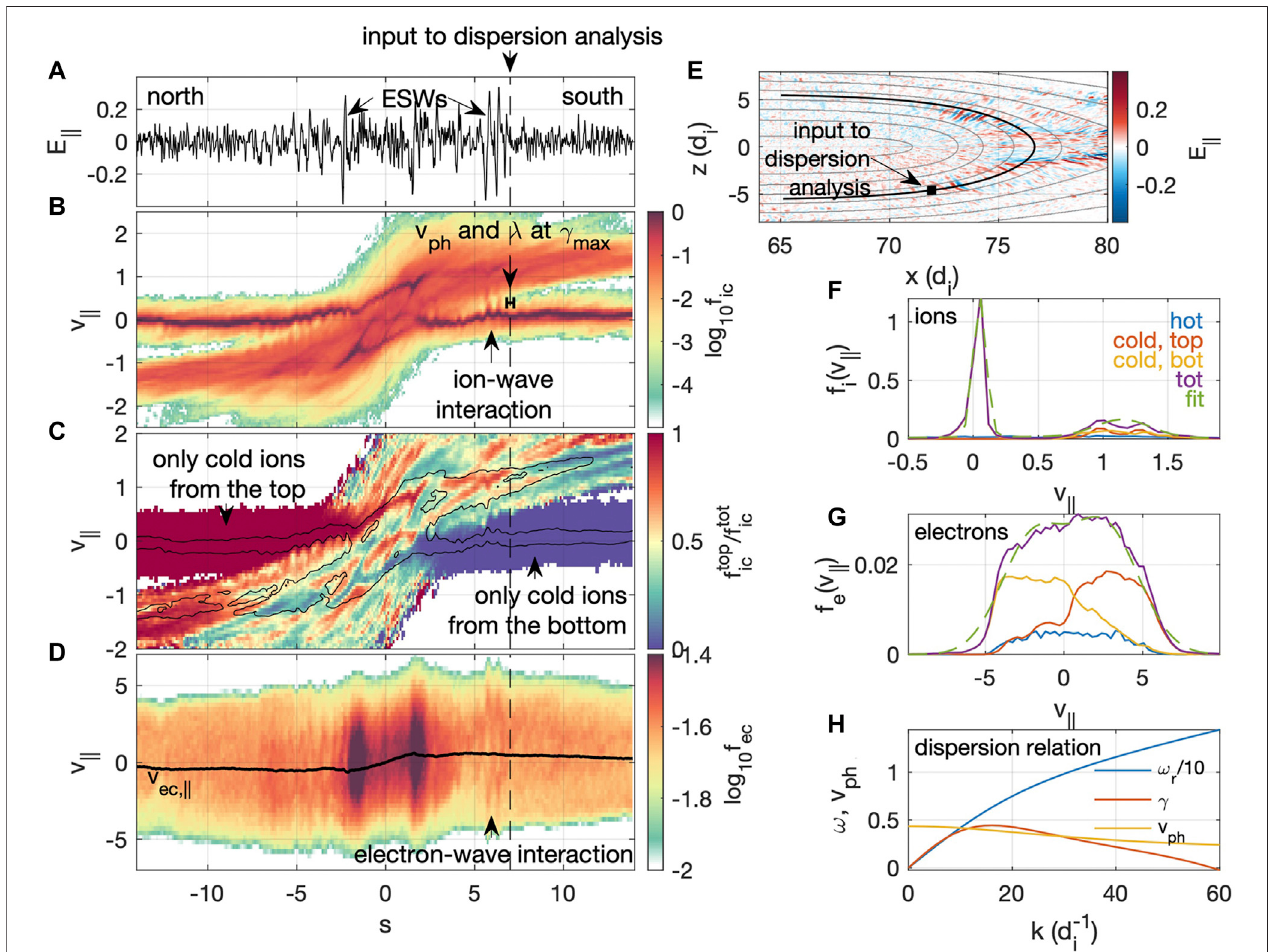
FIGURE8| Thermalizationduetoion-acousticwaveswithintheexhaust.Panels (A – E) showquantitiessampledalongamagnetic fi eldlinemarkedbytheblackline in panel (E) . They are plotted as a function of the distance along the fi eld line s , where s (cid:1) 0 is the equatorial plane and s > 0 is in the region z < 0 (since the magnetic fi eld directionisfromnorthtosouth). (A) Parallelelectric fi eld E (cid:4) . (B) Reducediondistributionofinitiallycoldions,log 10 f ic . (C) Mixinglevelofionsoriginatingfromthenorthand south, respectively, f mix (cid:1) f top ic / f ic . For f mix (cid:1) 1 (red) and 0 (purple), all the ions are originating from the top and bottom, respectively. For f mix (cid:1) 0.5 (yellow), half of the ions are originating from the top, and half from bottom. For reference we show log 10 f ic (cid:1) − 1 as black contours. (D) Reduced distribution of originally cold electrons, log 10 f ec . We have saturated the color scale to highlight the features in the region of the waves. (E) Parallel electric fi eld E (cid:4) . (F) Ion, and (G) electron distributions at the location marked by a black square in panel (E) , and the vertical dashed lines in (A – D) . The dashed green line marks a fi t to the data using three Maxwellians. (H) DispersionrelationobtainedbasedontheMaxwellian fi tsin (F – G) .Thepositivegrowthrateisduetoanion-acousticinstability.Thephasespeed v ph andwavelength λ at max growth c max is shown as a black bar in (B) .